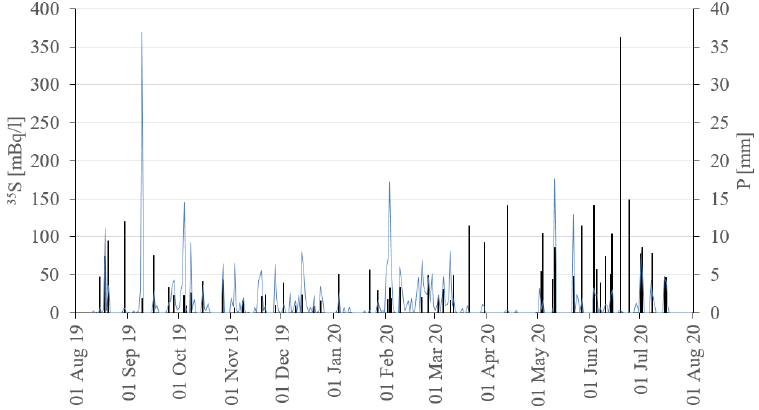
Figure 3. Complete twelve-month time series of 35 S activity in rain ( 35 S; black columns) and rain intensity (P, blue line).